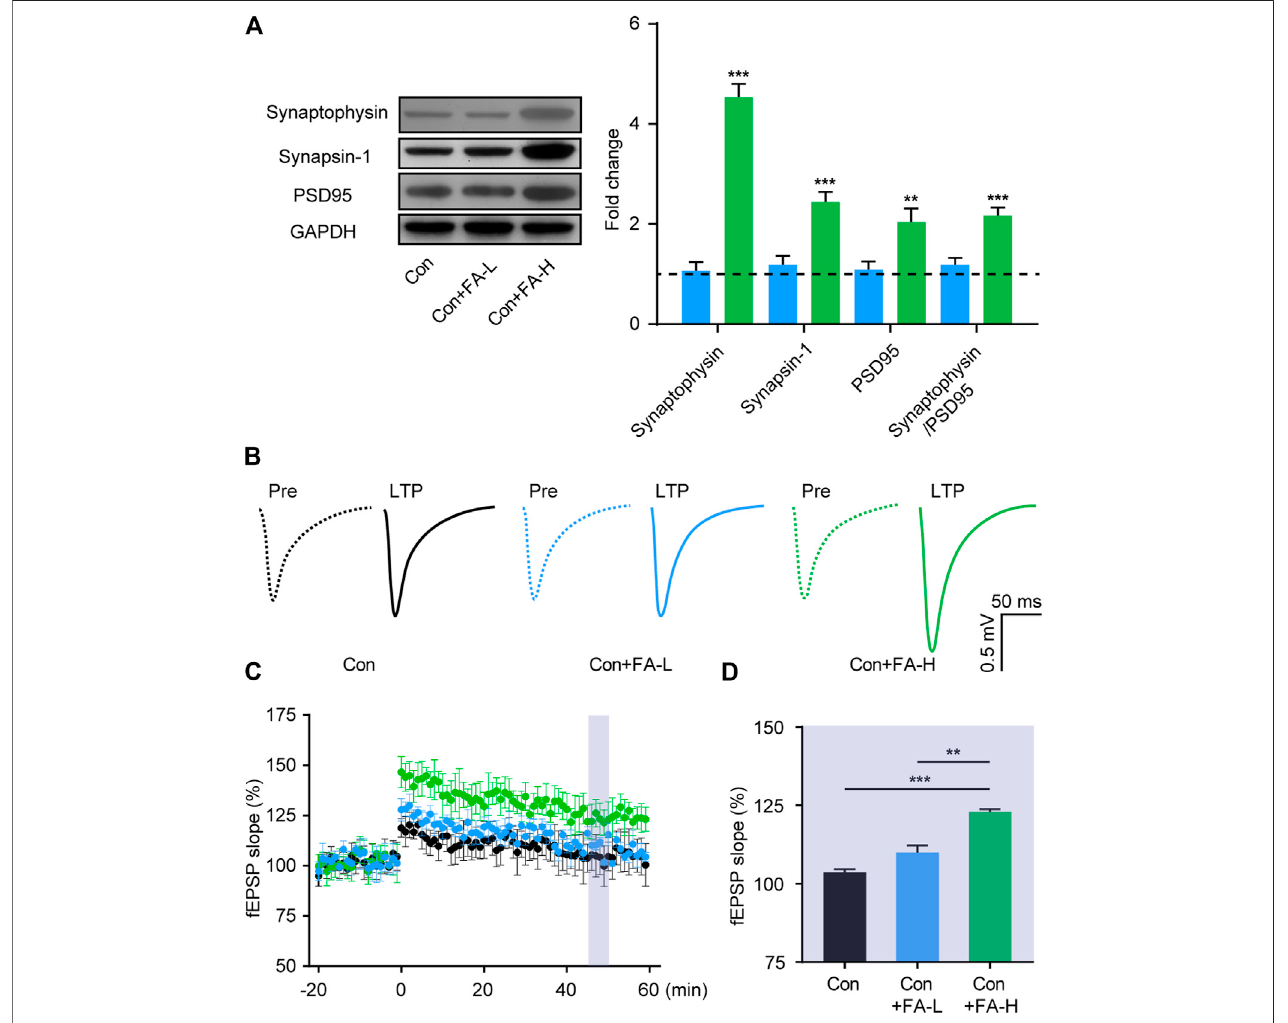
FIGURE 6 | Gestational FA administration promotes synaptic plasticity in postpartum female mice. (A) Representative immunoblots and quanti fi cations showing Synaptophysin,Synapsin-1andPSD95expressioninthehippocampus.SynaptophysinOne-wayANOVA:F(2,15) (cid:2) 79.19, p < 0.0001.Synapsin-1One-wayANOVA: F (2, 15) (cid:2) 33.79, p < 0.0001.PSD95One-way ANOVA: F (2, 15) (cid:2) 11.23, p (cid:2) 0.0010. Synaptophysin/PSD95One-way ANOVA: F (2, 15) (cid:2) 17.57, p (cid:2) 0.0001. The Con group was normalized as a dotted line, and the statistical results were compared with the Con group. (B) Representative traces of fEPSP responses during LTP induction. Scale, 0.5 mV, 50 ms. (C) Time-course responses ofthe evoked LTP potentialsfollowing high frequency stimulation (HFS) at CA3-CA1 synapses. The points in the time scale axis were normalized to the average baseline response to show the fEPSP slope. (D) Area in the shadow showed the averaged %fEPSP slope